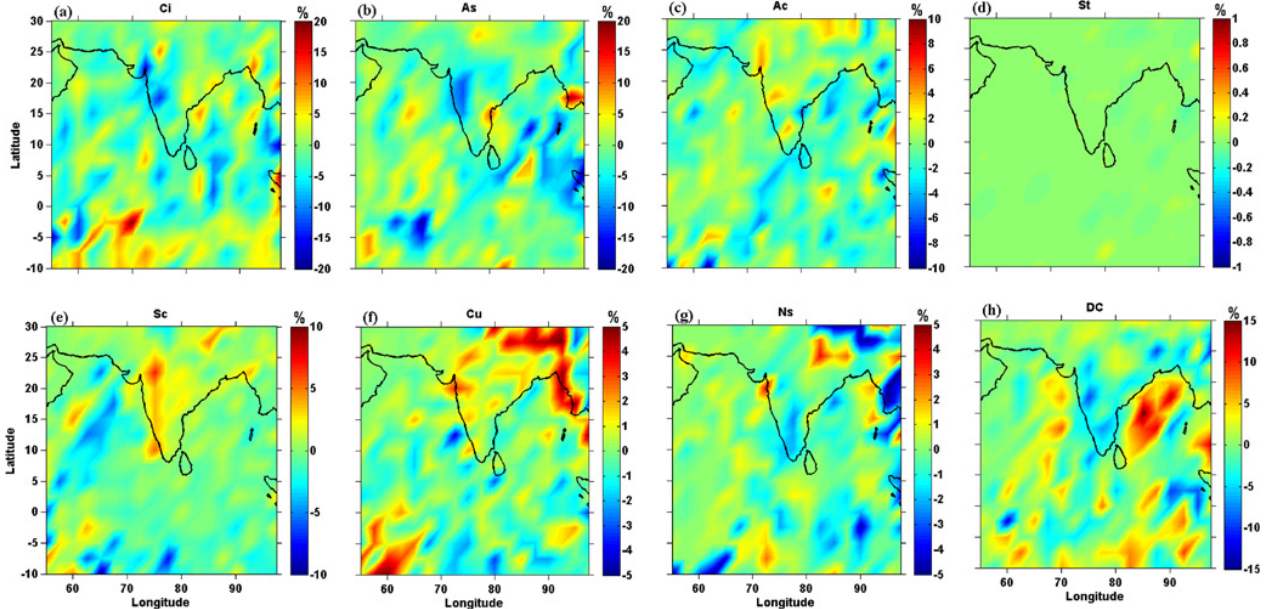
Fig. 2. Same as Fig. 1 but for differences in frequency of occurrence during day- and